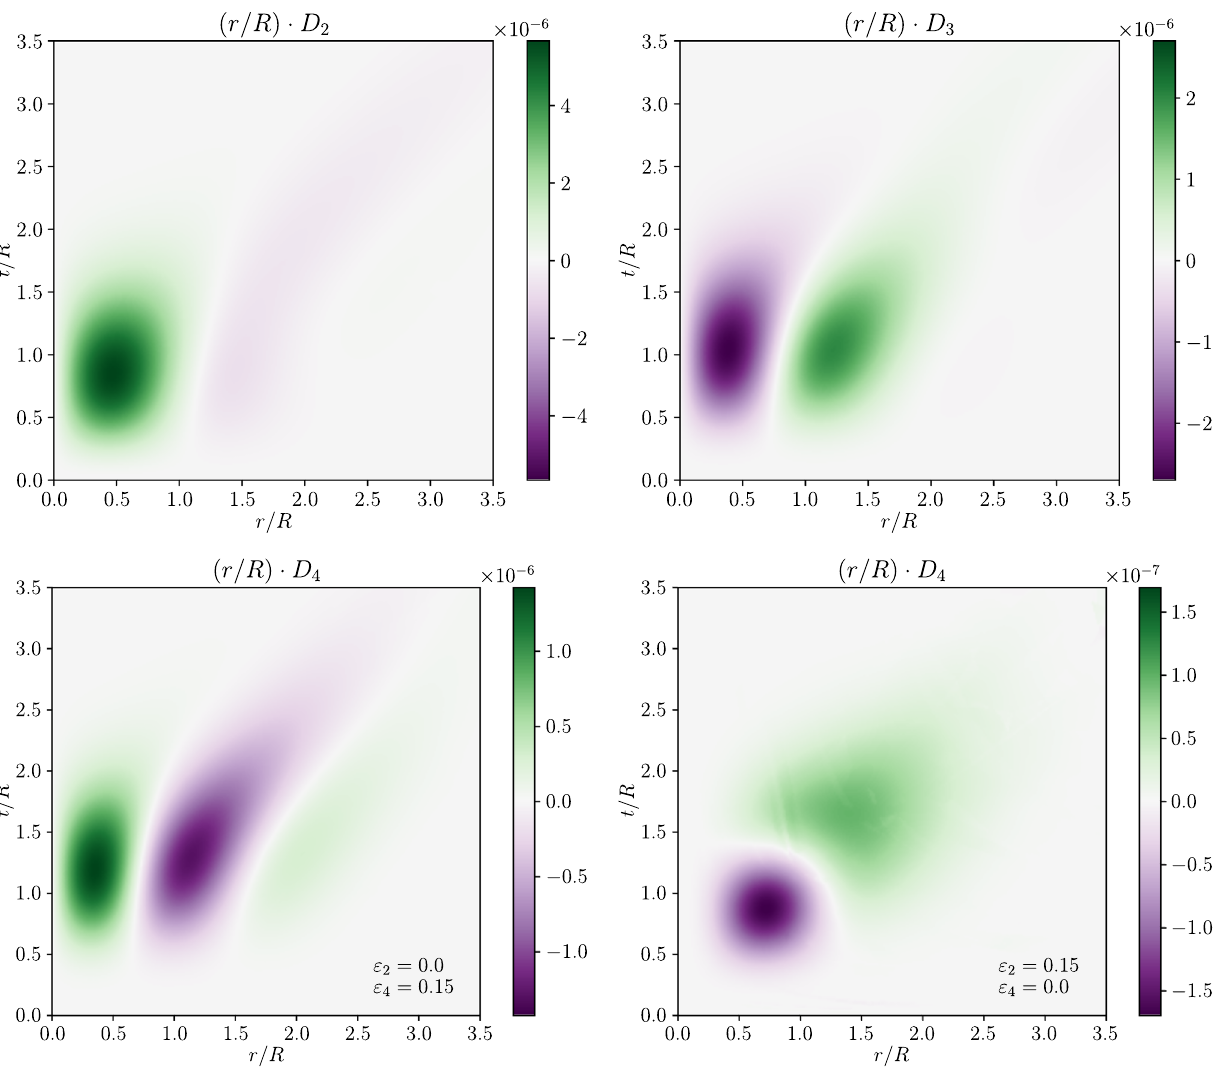
Fig. 10 Angle-averaged local production rates D 2 (upper left), D 3 (upper right), and D 4 for an initial state with ε 2 = 0 and ε 4 = 0 . 15 (bottom left) or with ε 2 = 0 . 15 and ε 4 = 0 (bottom